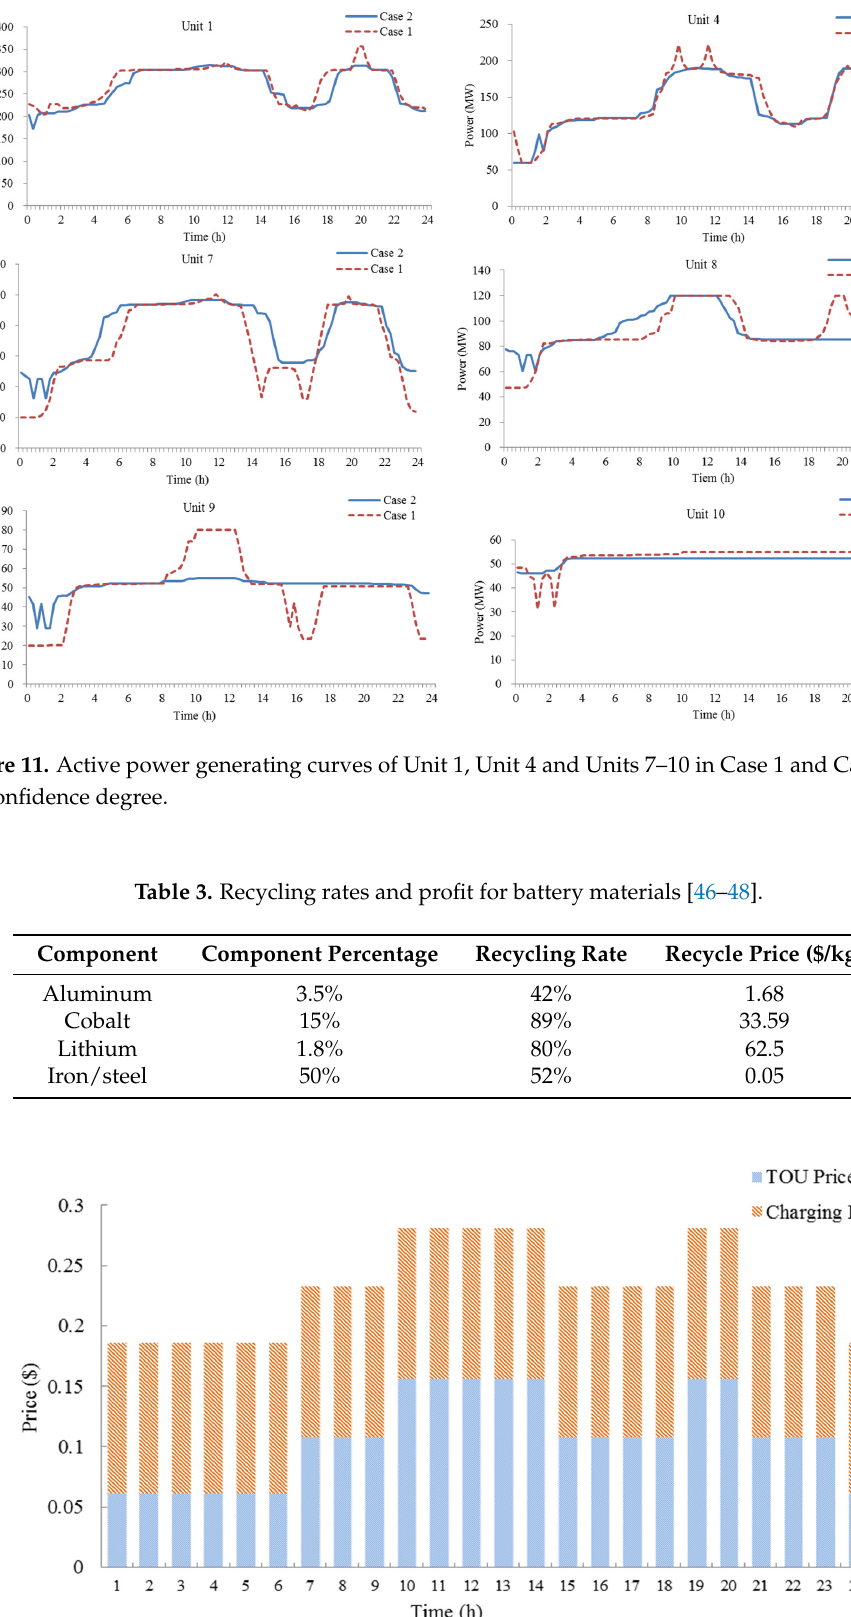
Figure 12. Time ‐ of ‐ use (TOU) electricity price and charging fee.